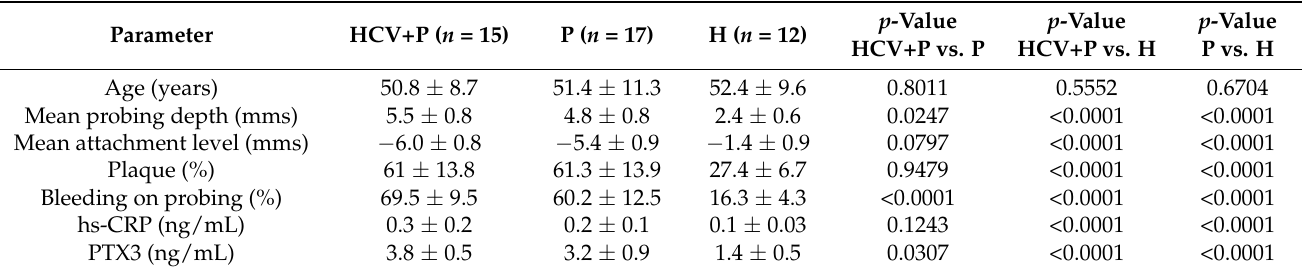
Table 1. Average ± standard deviation and statistical significance of analyzed parameters before treatment.